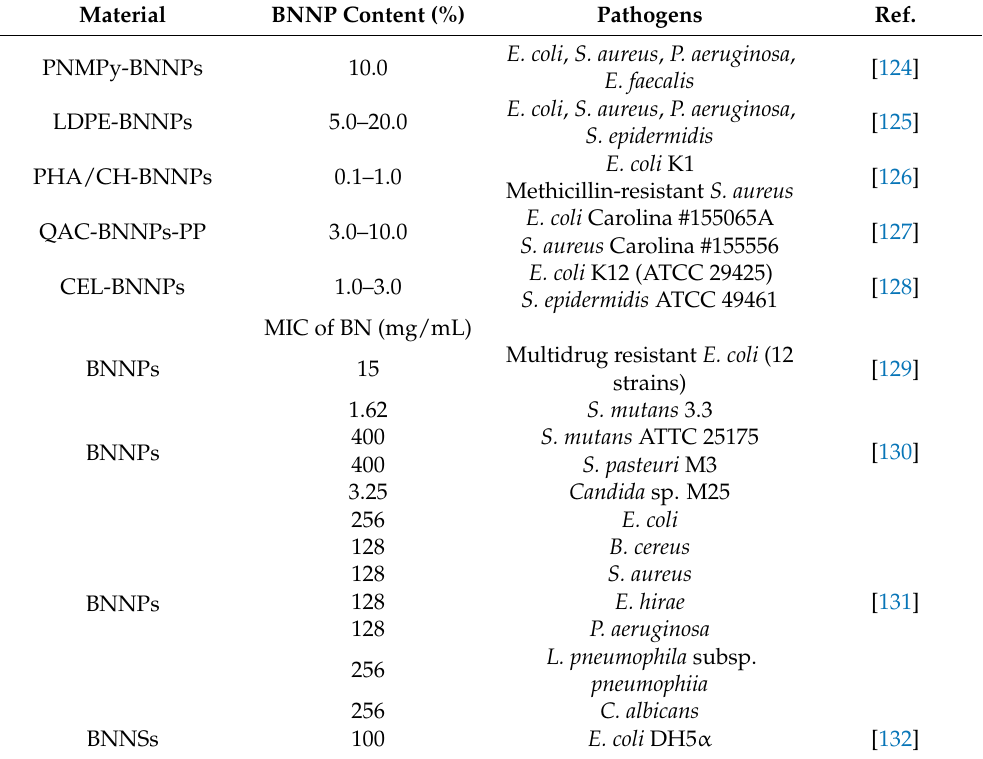
Table 1. Antibacterial activity of BN NPs and BN-based